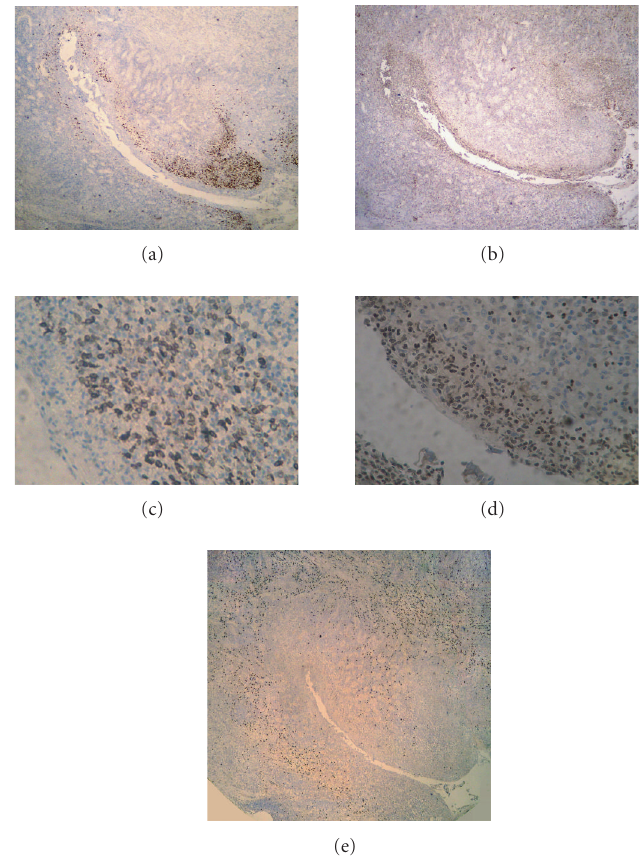
Figure 2: Spatial distributions of COX2, 5-LO, and 15-LO-1 in Crohn’s ulcer. (a) COX2 immunoreactivity in ulcer surface. Note that the utmost superficial layer was negative for COX2 (magnifications: × 40). (c) COX2 immunoreactivity in ulcer in higher magnification: × 400. (b) 5-LO immunoreactivity in ulcer surface. Note the clear border of surface 5-LO-positive neutrophils (magnifications: × 40). (d) 5-LO immunoreactivity in higher magnification: × 400. (e) 15-LO-1 immunoreacivity in Crohn’s ulcer, which formed a cu ff -like structure around the U-shaped ulcer. Note that these cells surrounded the granulation region (magnifications: × 40) representative of similar